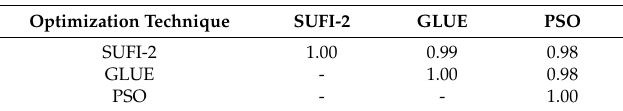
Table 9. Correlation coefficient among the best simulation of discharges obtained by all optimization techniques in all stations at Salman Dam Basin